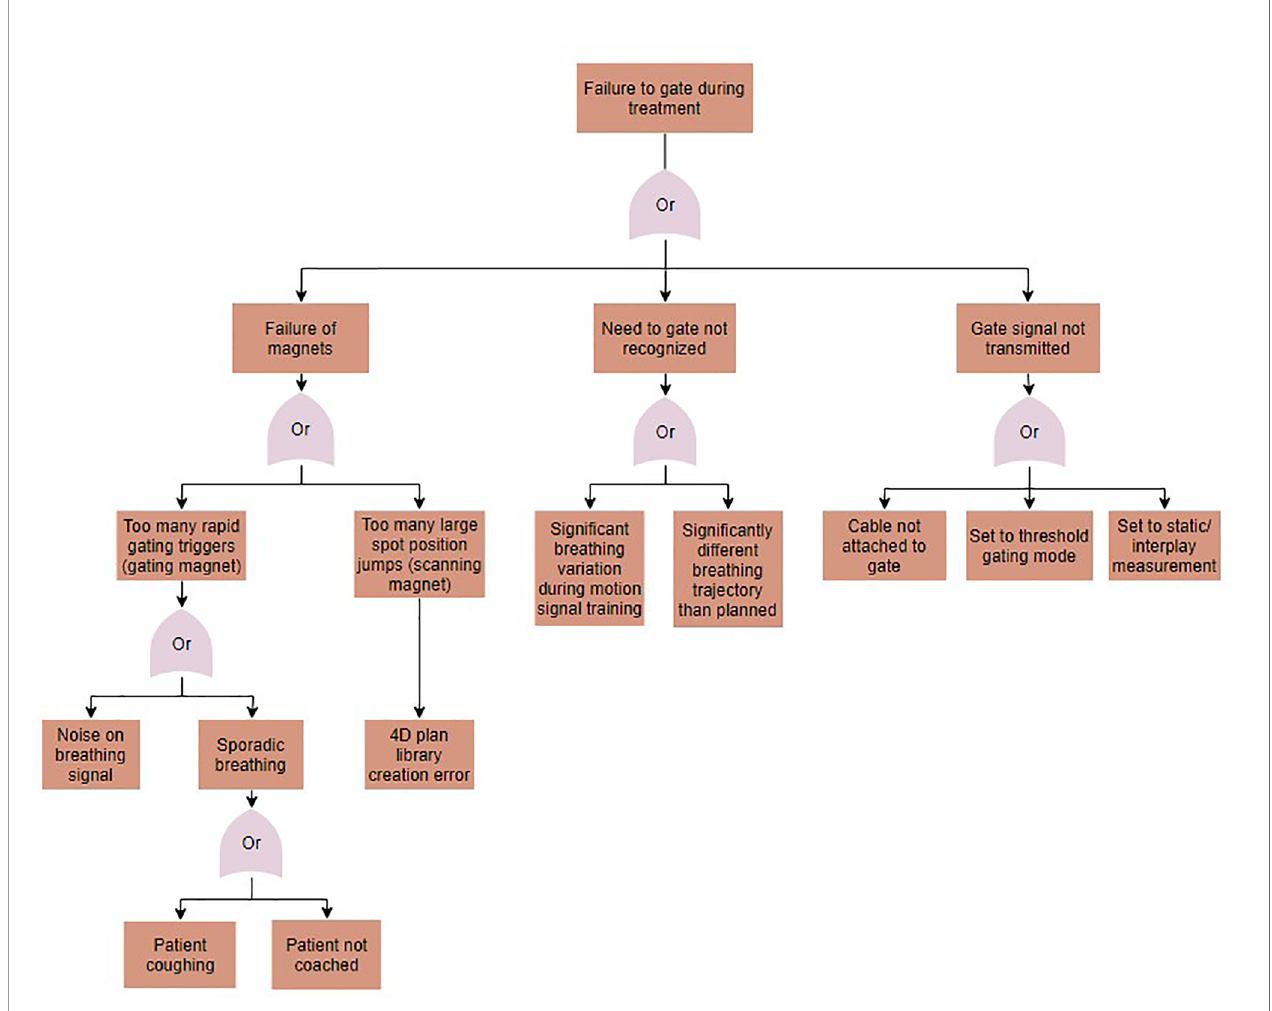
FIGURE 5 | A fault tree analysis for the case of gating failures during motion-synchronized dose